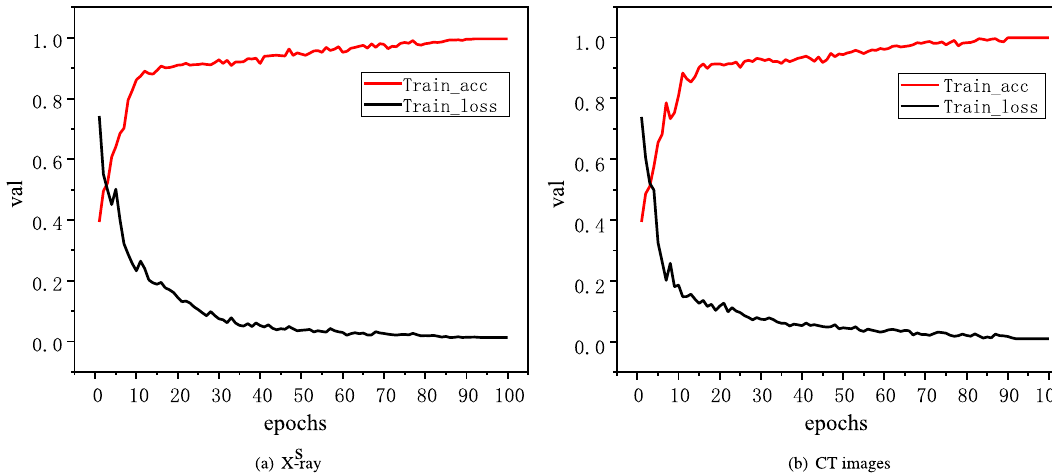
Figure 4. Train_loss and Train_acc curves of X-ray and CT